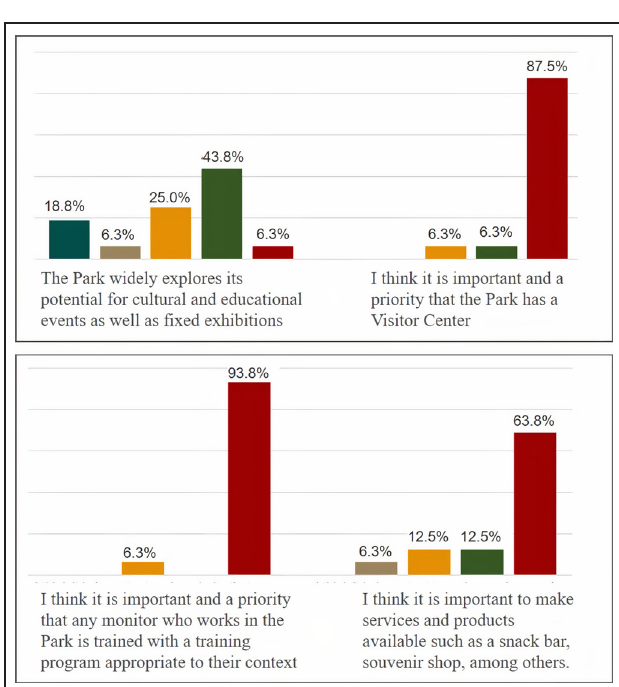
FIGURE 8 . Perceptions of stakeholders on the use of structure holding events, providing products and services, visitor centre and monitors training.